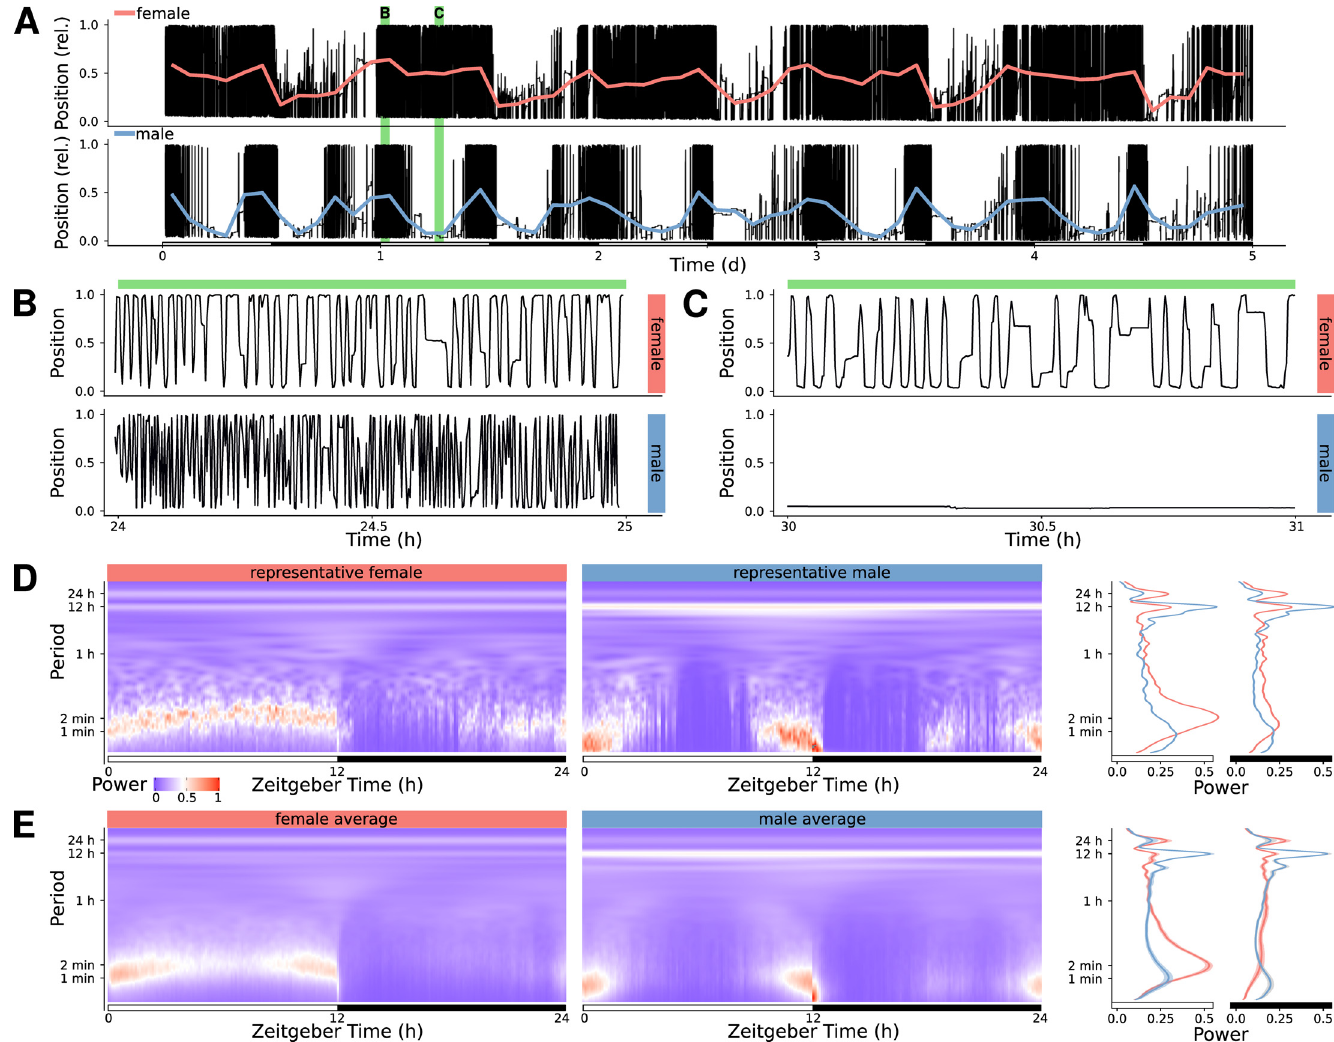
Fig 6. Wavelet analysis of positional data. A: Raw position data for a representative female (top) and male (bottom) Drosophila melanogaster over five days, in black. The thick coloured lines show the average position every two hours. The green rectangles in the background show the two time windows selected for B and C. B: Close up of the first time window in A, showing position over one hour, starting at the beginning of the L phase of day 1. C: Close up of the second time window in A, showing position over one hour, starting at the middle of the L phase of day 1. D: Continuous wavelet transform spectrogram for the two representative animals. E: Average spectrogram across 40 males and 40 females. In D and E, the lines on the right show the marginal power spectra corresponding to the spectrograms shown— that is the average across 12 hours in either the light (white bar) or dark (black bar) phase. The male data was collected and described in our previous study [21] (controls in Fig 5M–5P) and the females data was acquired in parallel, in the same experimental conditions, but not previously published.